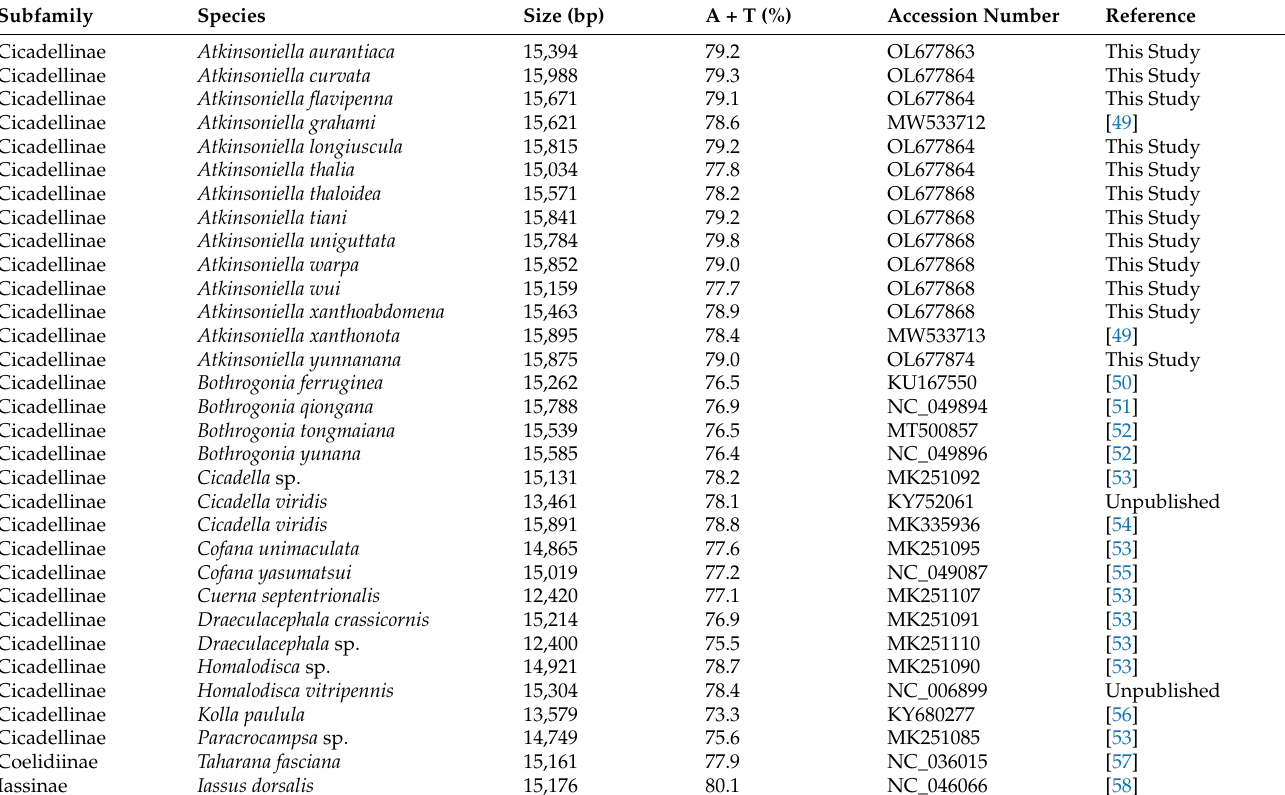
Table 1. Mitochondrial genomes used for the phylogenetic analyses in this